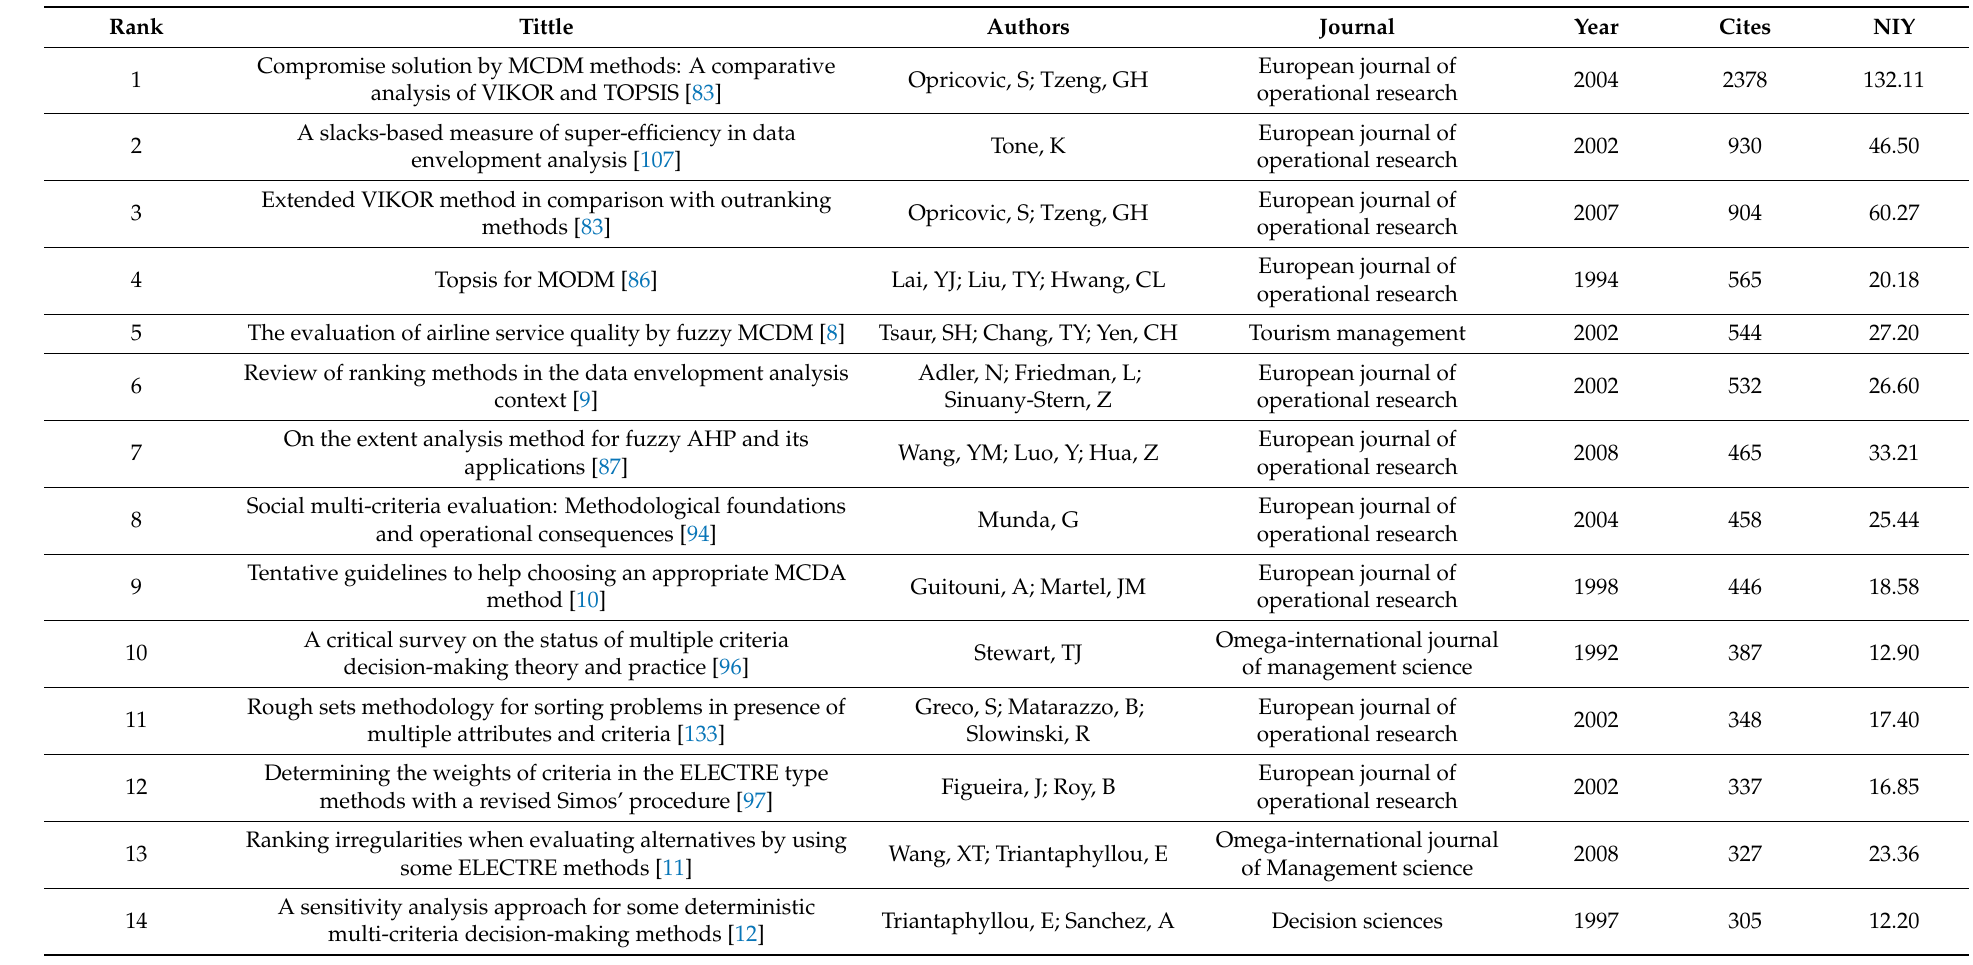
Table A1. Top 25 articles by citations. Subperiod 1